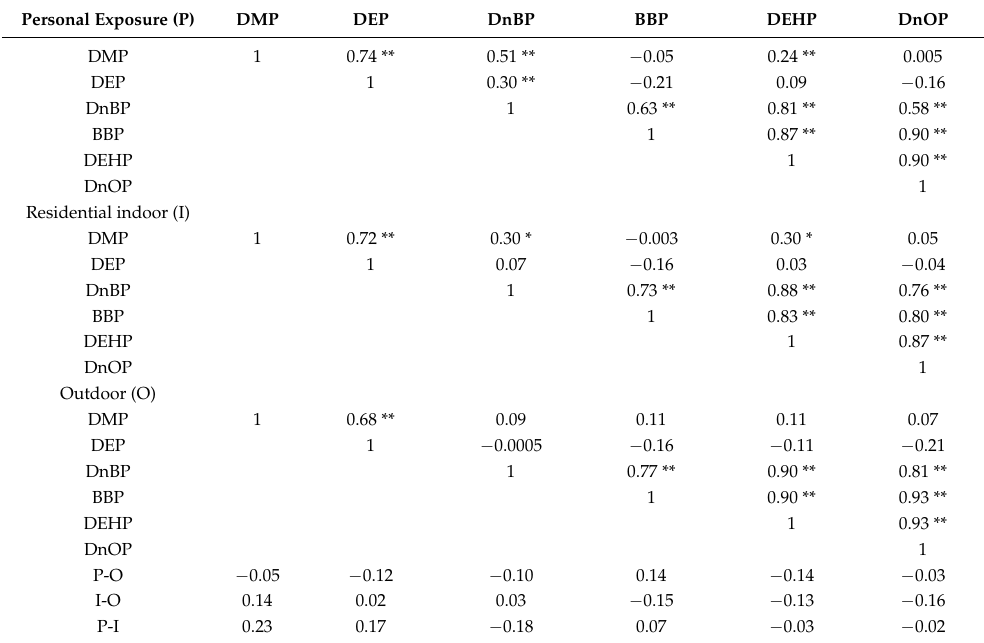
Table 4. Spearman’s correlation matrix for PM 2.5 -bound PAE congeners in (and between) personal exposure, residential indoor, and outdoor, respectively.